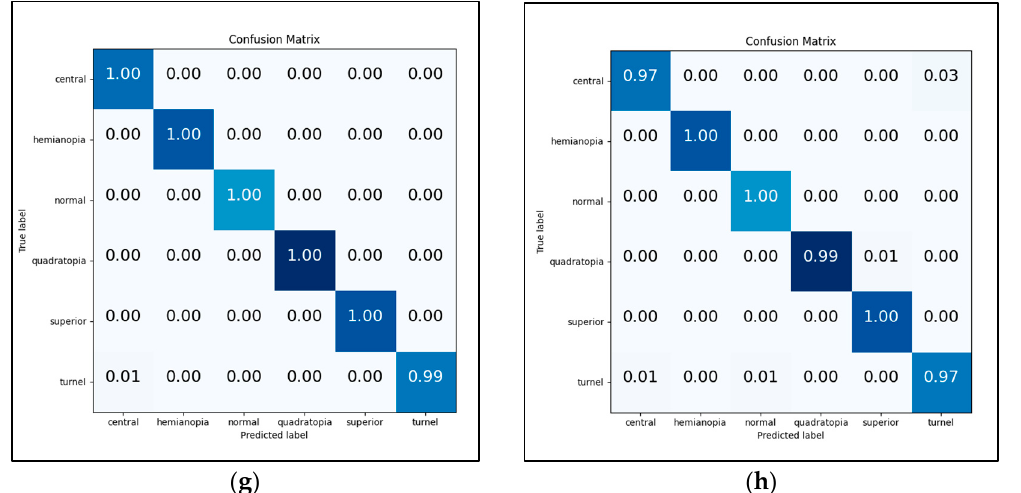
Figure 12. Confusion matrices for VGG-Net, MobileNet, ResNet, and DenseNet: ( a ) Confusion matrix for VGG-16; ( b ) Confusion matrix for VGG-19; ( c ) Confusion matrix for MobileNet; ( d ) Confusion matrix for MobileNetV2; ( e ) Confusion matrix forf ResNet-50; ( f ) Confusion matrix for ResNet-101; ( g ) Confusion matrix for DenseNet-121; ( h ) Confusion matrix for DenseNet-169.